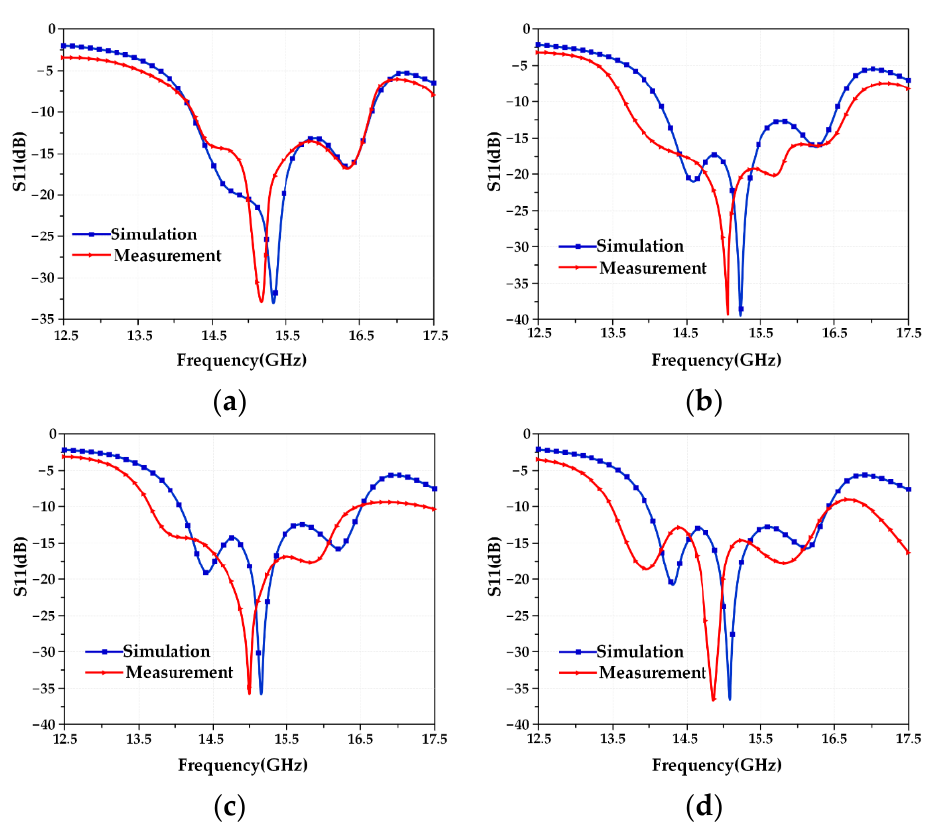
Figure 17. S11 curves of the Mode 1 antenna under four working conditions. ( a ) Working condition 0; ( b ) working condition 1; ( c ) working condition 2; ( d ) working condition 3.